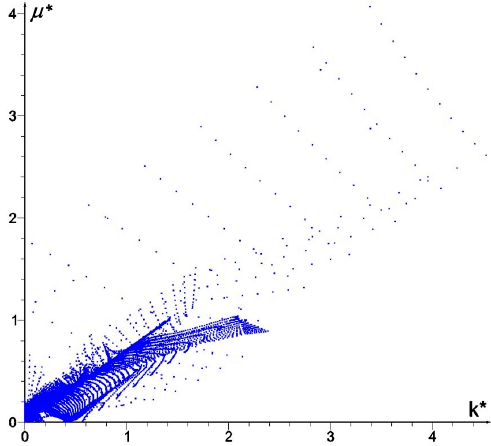
Figure 4. Distribution of optimal pairs of points ( k *, μ *).